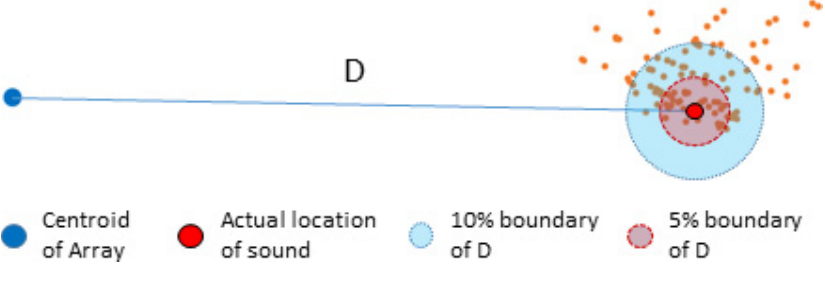
Figure 14. Point-cloud sparsity